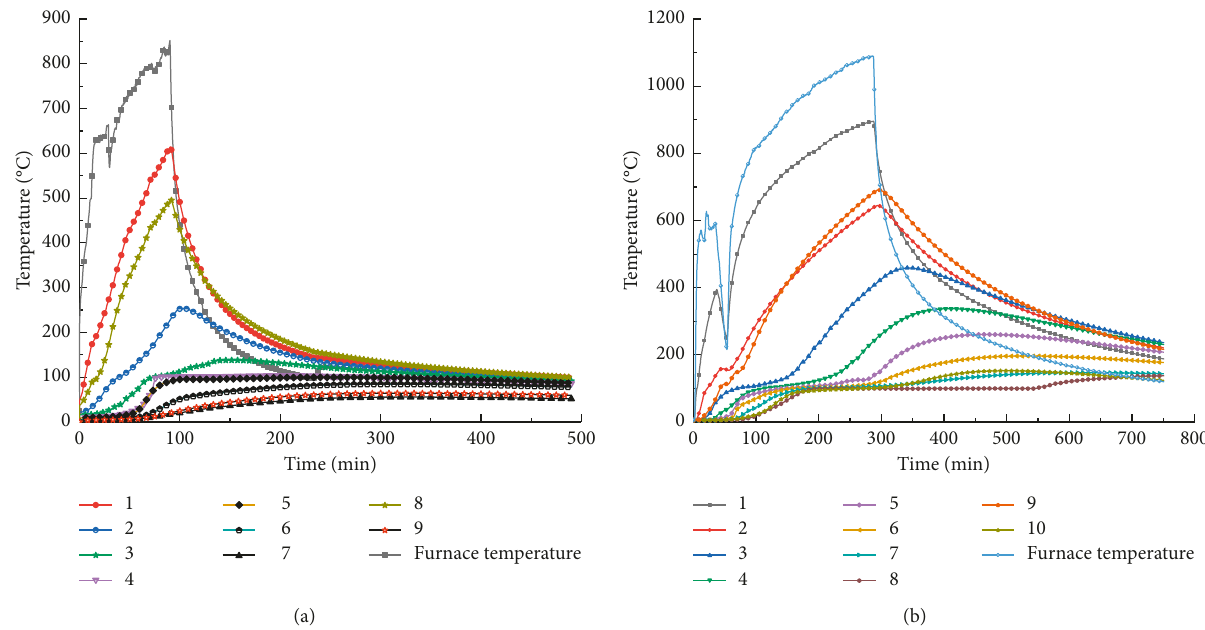
Figure 9: Temperature-time relationships of ribbed girders. (a) The first slab. (b) The second